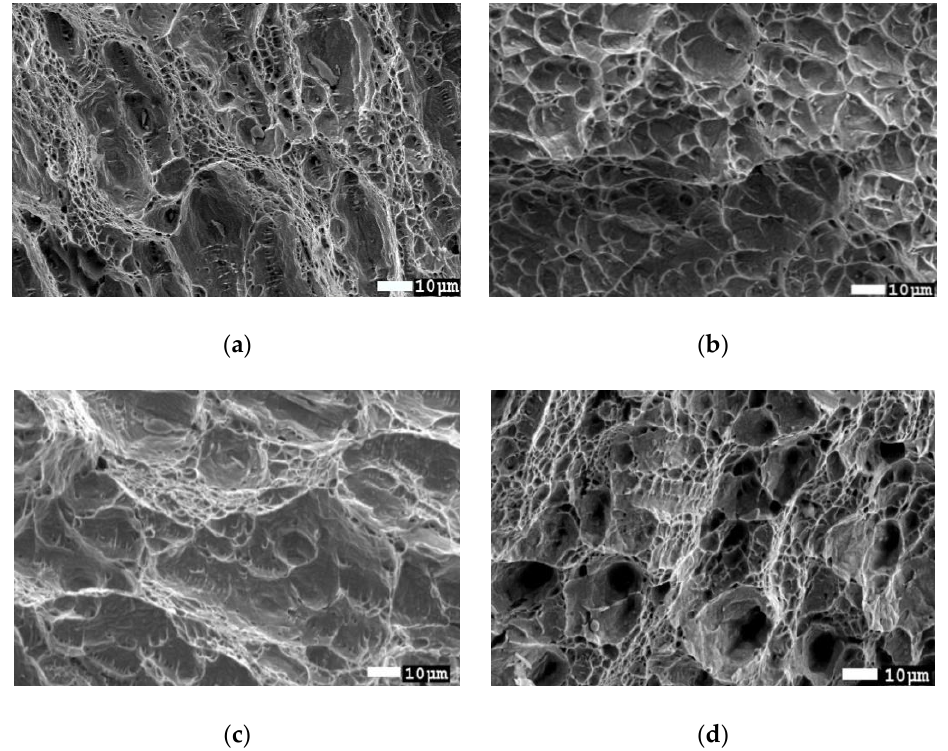
Figure 16. Fractographs of impact test in: ( a ) TIG weld zone; ( b ) ATIG weld zone; ( c ) TIG heat affected zone and ( d ) ATIG heat affected zone.